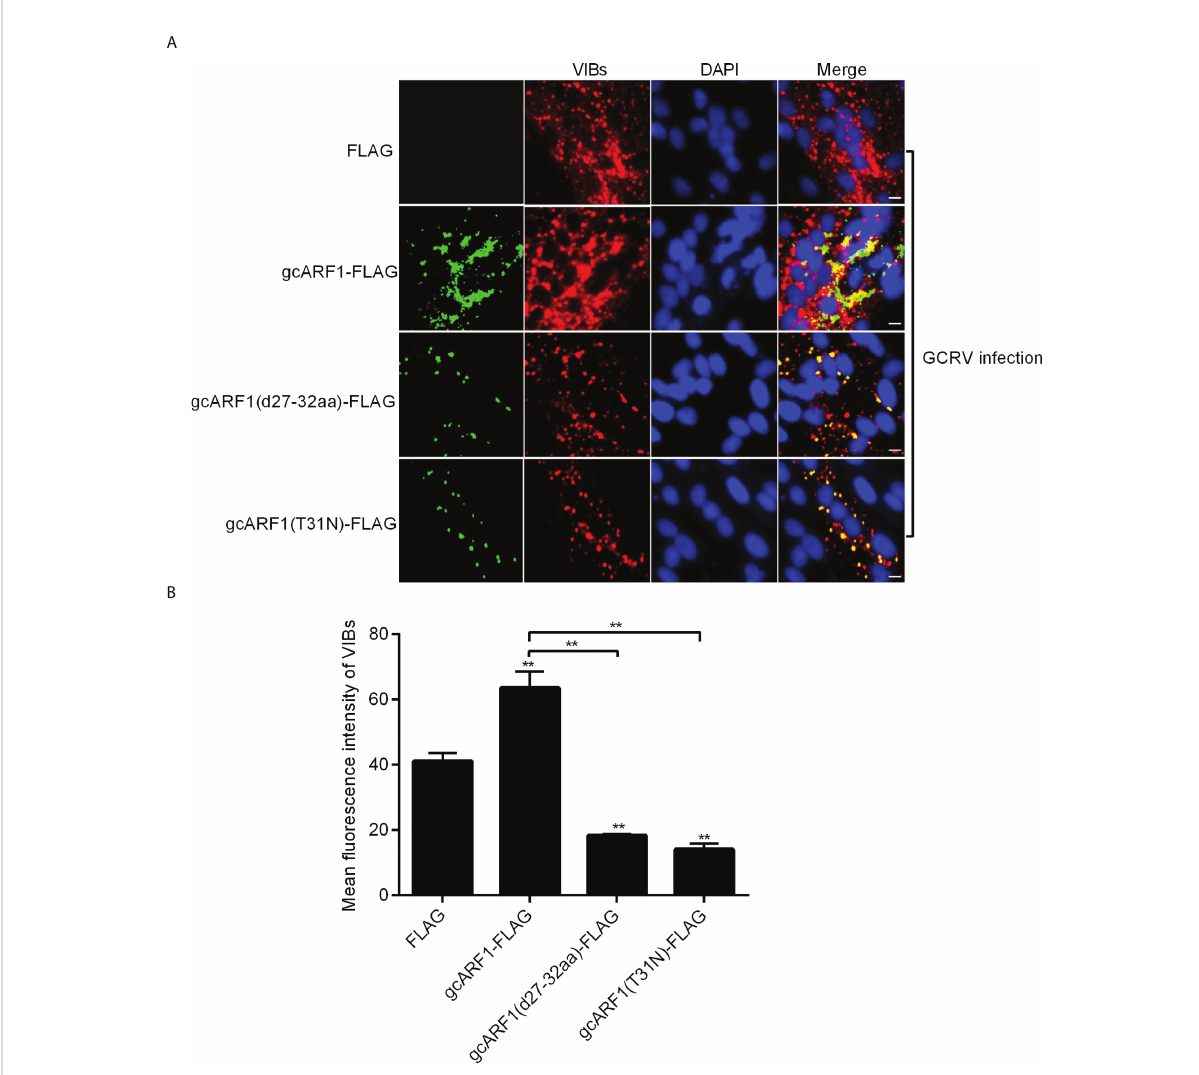
FIGURE 8 The 27 AAGKTT 32 motif and T 31 residue are required for the generation of VIBs. (A) Immuno fl uorescence analysis for VIBs in CIK cells that were transfected with FLAG, gcARF1-FLAG, gcARF1(d27-32aa)-FLAG or gcARF1(T31N)-FLAG, respectively. Scale bars, 10 µm. (B) The average fl uorescence intensity of VIBs in CIK cells that were transfected with FLAG, gcARF1-FLAG, gcARF1(d27-32aa)-FLAG or gcARF1(T31N)-FLAG, respectively. Data were tested for statistical signi fi cance. ** p < 0.01. The asterisk above the error bars indicated statistical signi fi cance using the group transfected with FLAG as the control group. The asterisk above the bracket indicated statistical signi fi cance between the two groups connected by the